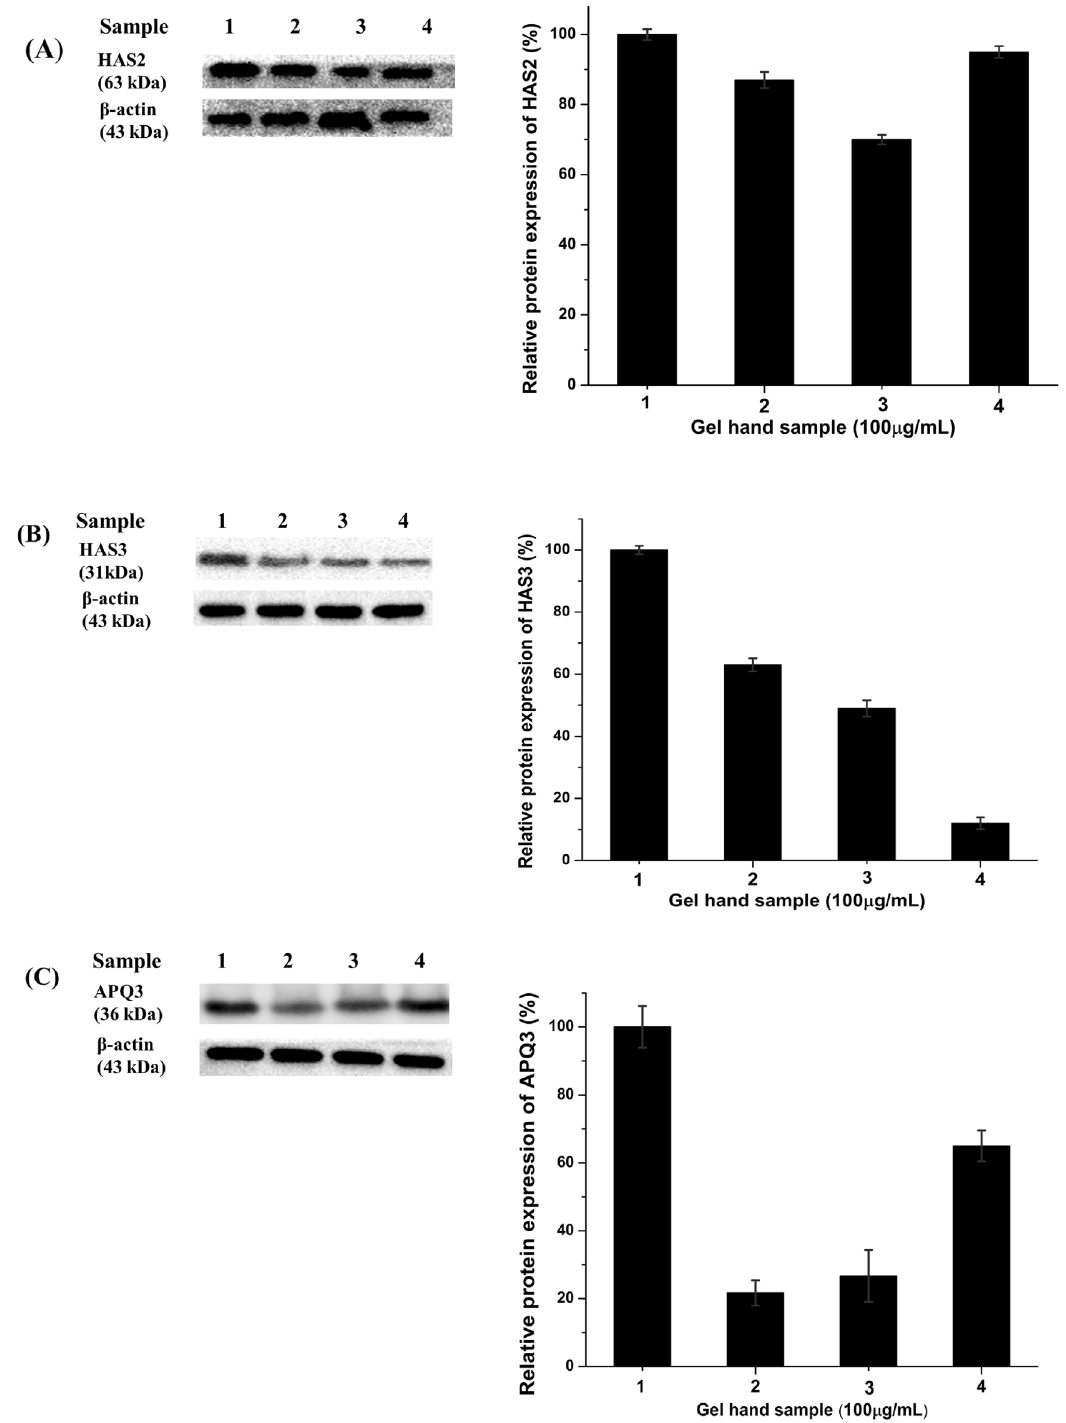
Figure 4. Moisturizing effects of hand gel in HaCaT cells. Expression levels of moisturizing-related proteins [HAS2 ( A ), HAS3 ( B ), and APQ3 ( C )]. The results are expressed as mean ± standard error of mean, n =